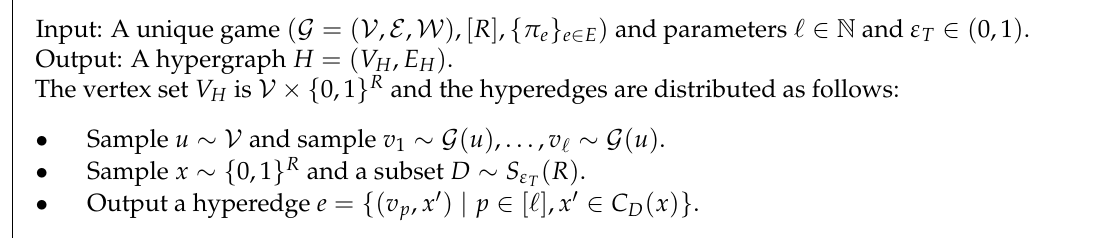
Figure 1. A Candidate Reduction from UG to